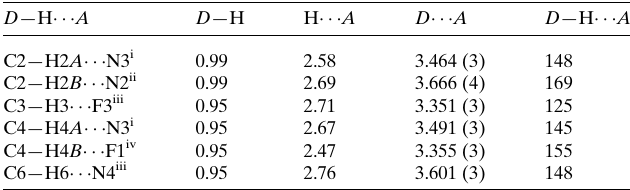
Table 1 Hydrogen-bond geometry (A˚ , (cid:2) ).